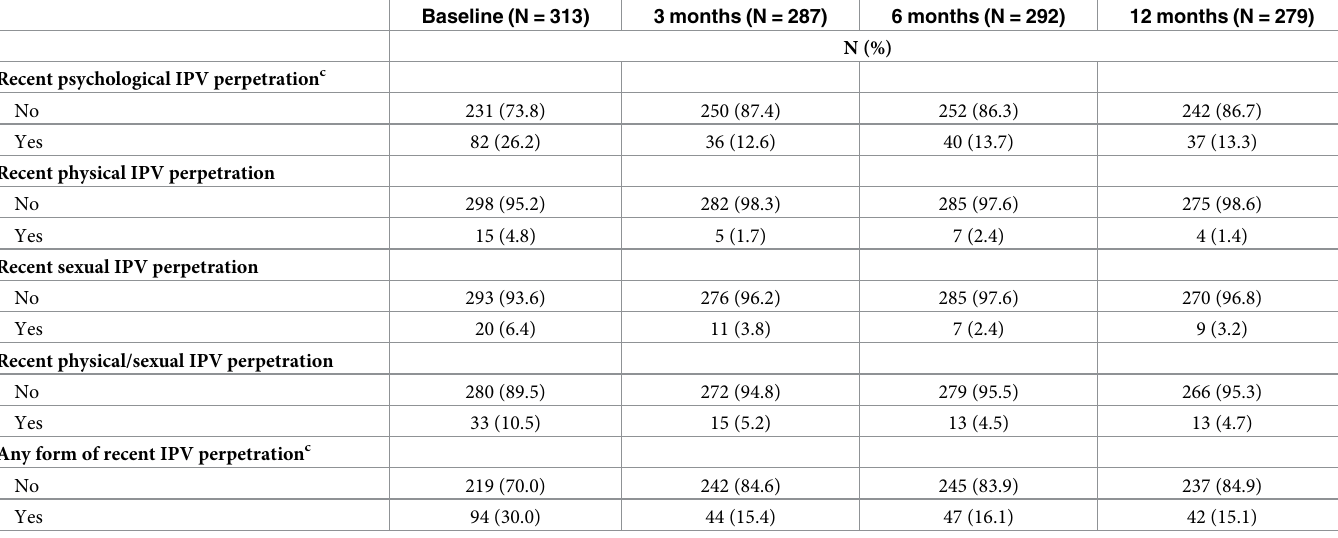
Table 2. Prevalence of intimate partner violence perpetration across study visits a,b .